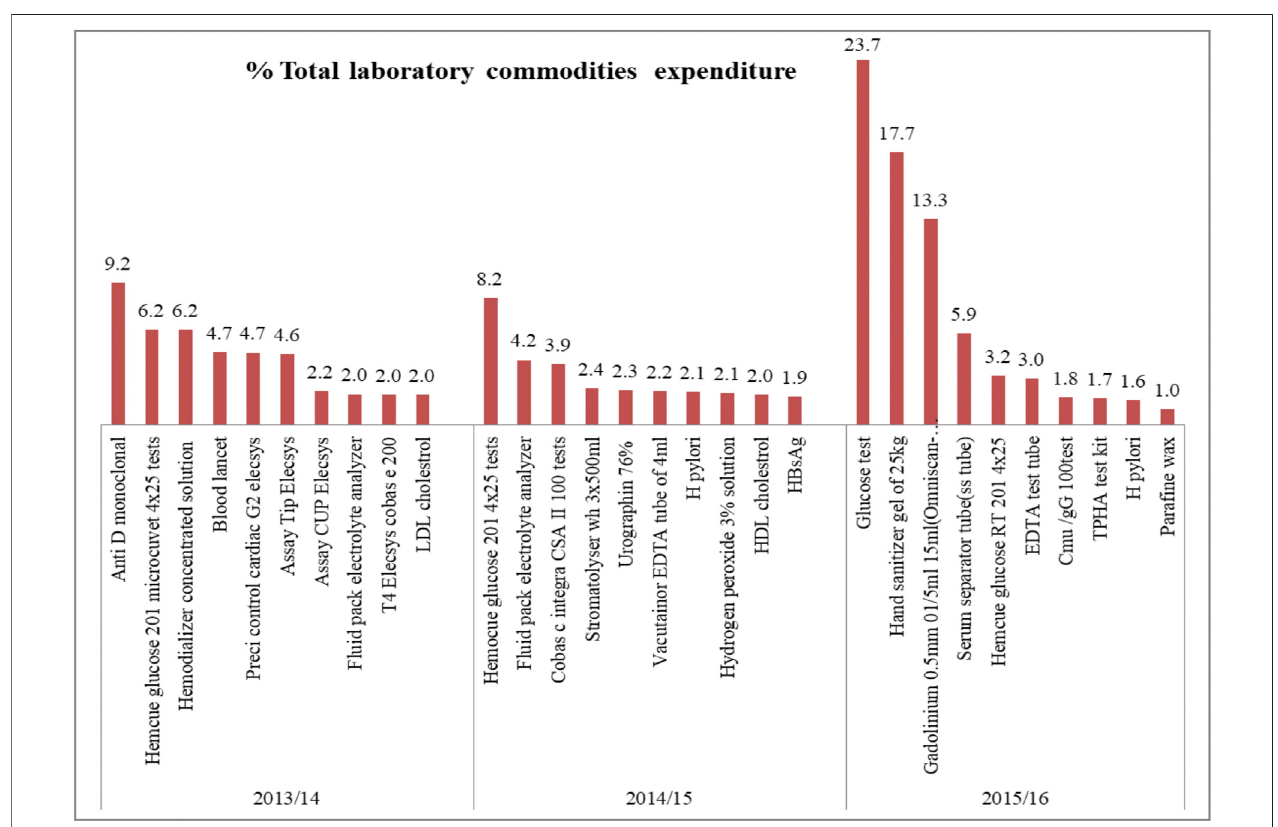
FIGURE 4 | Top ten (based on cost) class “ A ” laboratory commodities in SPHMMC (2013/14 – 2015/16), March 2017.